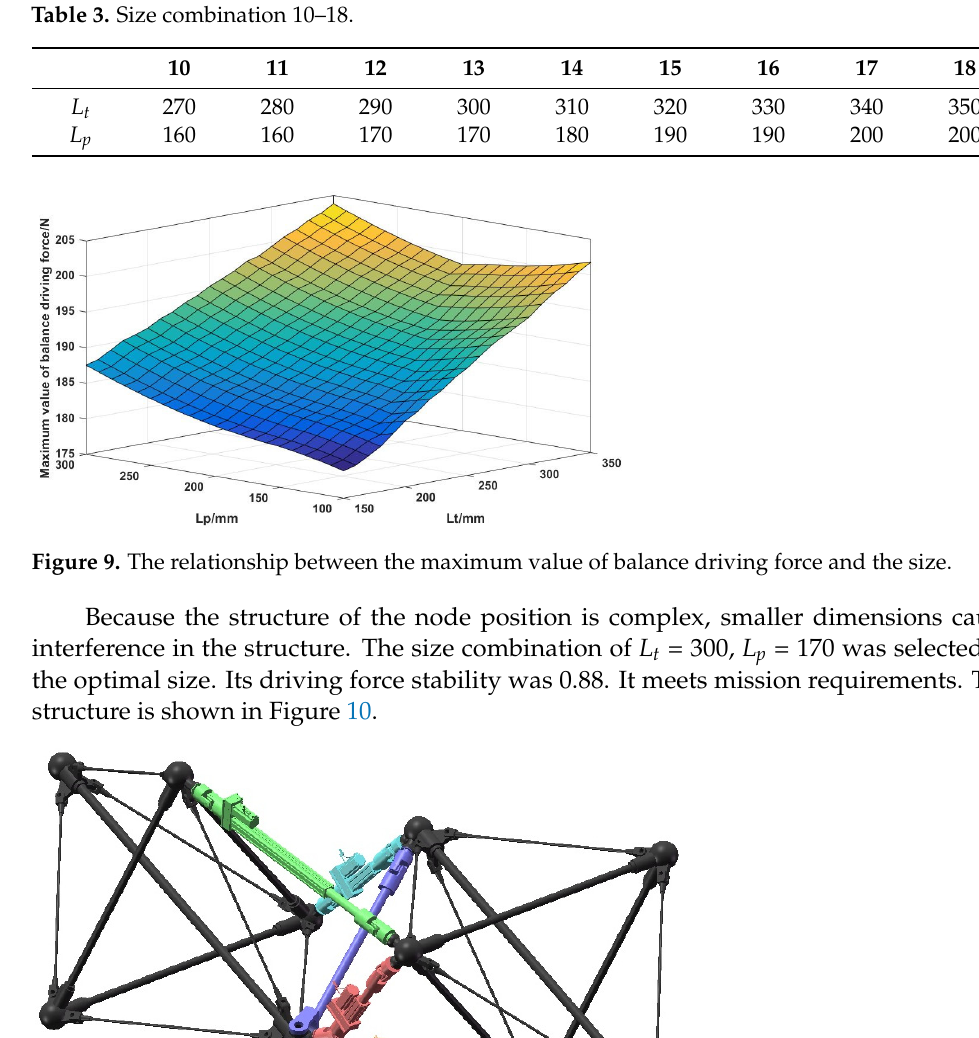
Figure 10. Three-dimensional figure of the basic unit of morphing wing.